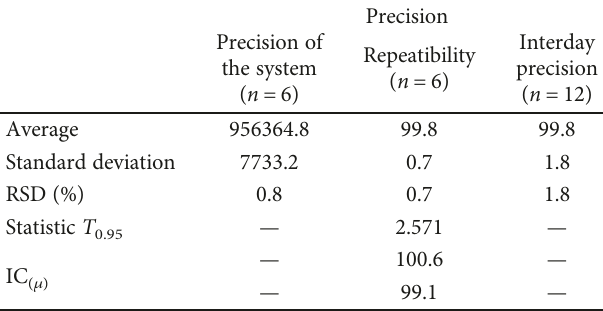
Table 2: Precision results for ketorolac in wastewater.